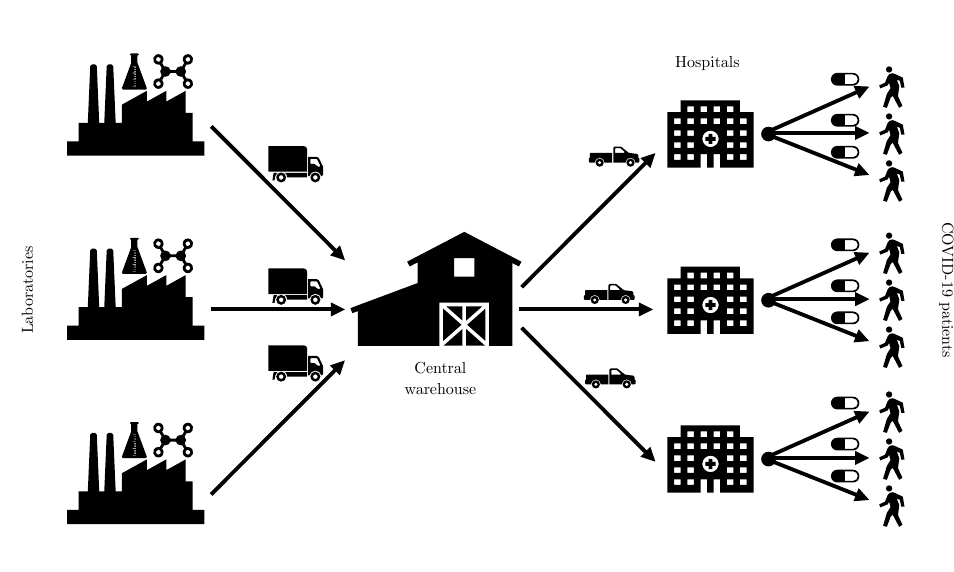
Figure 1. Scheme of drug demand data collected through